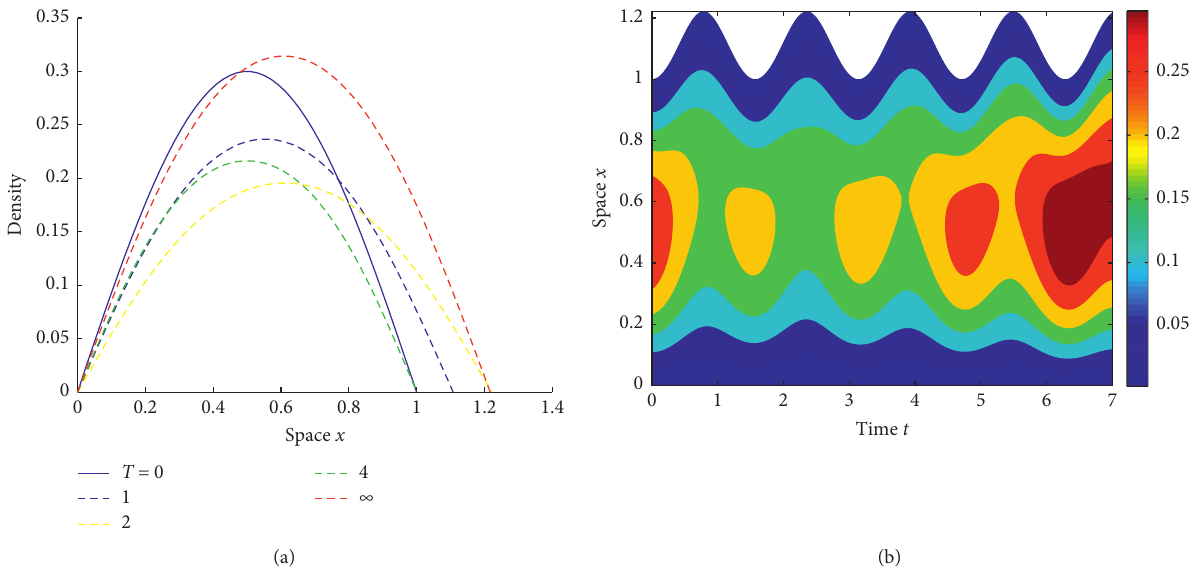
Figure 6: The corresponding cross-sectional view (a) and contour one (b) for the solution of problems (7) and (9), which implies that the domain is periodically evolving when the evolution rate ρ ( t ) � e 0 . 1 ( 1 − cos ( 4 t )) .